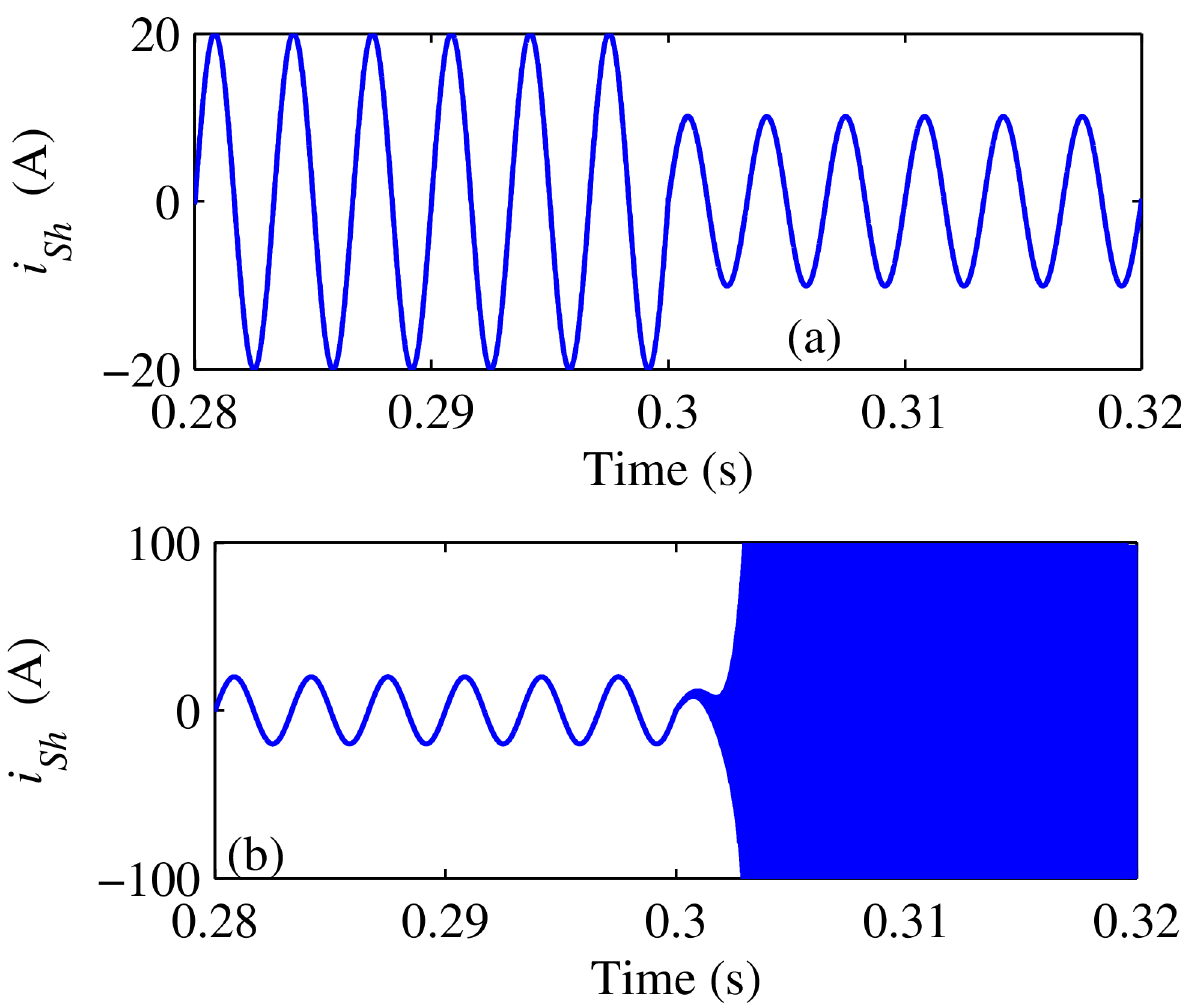
Fig 6. Performance of traditional R-APF algorithm: (a) With K Vh set to 0.95/ Z eqh ; (b) With K Vh set to 1.05/ Z eqh .